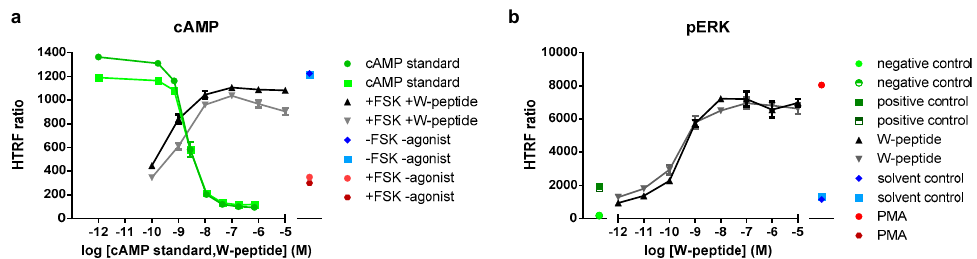
Figure A3. Exemplary raw data of concentration-response curves for FPR1-mediated stimulation of ( a ) cAMP production and ( b ) MAPKinase activation. In addition to the W-peptide measurements, data points for the cAMP standards and the ERK positive and negative controls included in the kit are shown. Data were normalized to the maximum output as obtained with forskolin and PMA.